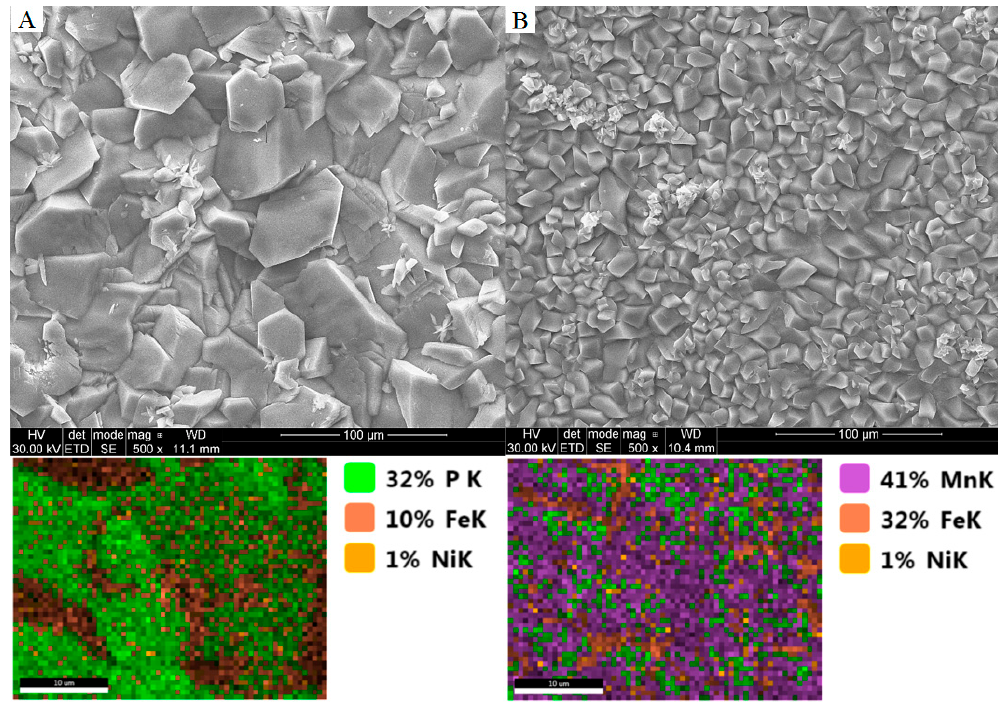
Figure 13. SEM images of the obtained coatings: ( A ) The manganese phosphating coating without the activation process; and ( B ) the manganese phosphating coating with the activation process. Table 9. The chemical composition for samples A (Mn_0), B (Mn_2.0), C and D based on EDX analysis. Element Materials 2018 , 11 , x FOR PEER REVIEW 17 of 24 Table 10. The values of corrosion potential, current density, and corrosion rate estimated for samples that underwent the activation and passivation processes.